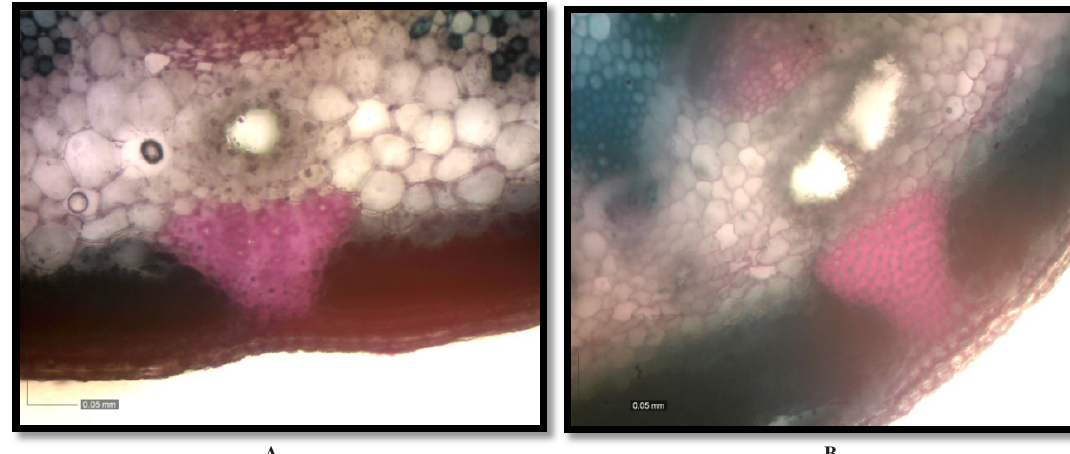
A B Fig. 1: Number of secretory duct in outcross (A) and self-pollinated (B) fennels.